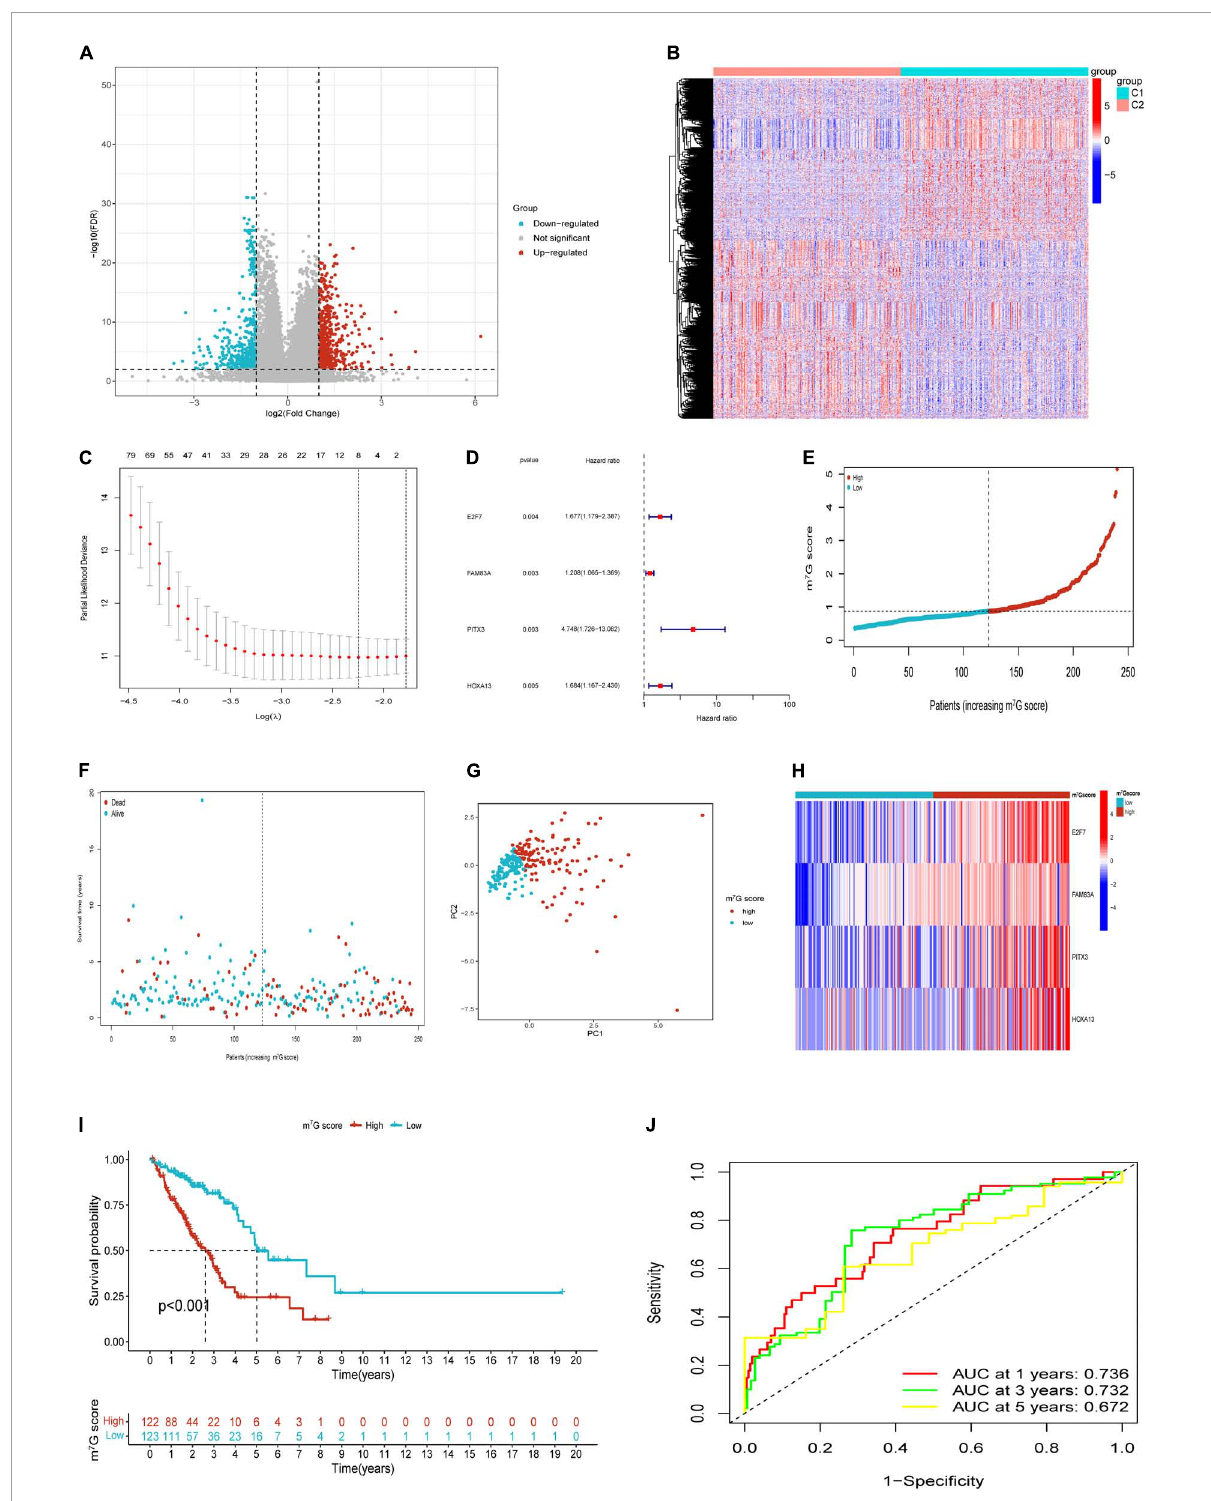
FIGURE5 Construction of m 7 G related signature based on TCGA train cohort. (A) Volcano plot of DEGs. (B) Heatmap of DEGs. (C) Eight genes through Lasso regression analysis. (D) Four key genes through multivariate Cox regression. (E,F) Distribution of m 7 G score and survival state. (G) Distribution of patients according to m 7 G-related signature. (H) Heatmap of four genes expression between high and low m 7 G score groups. (I) Survival analysis in two groups. (J) AUC for predicting 1-, 3-, 5-years survival